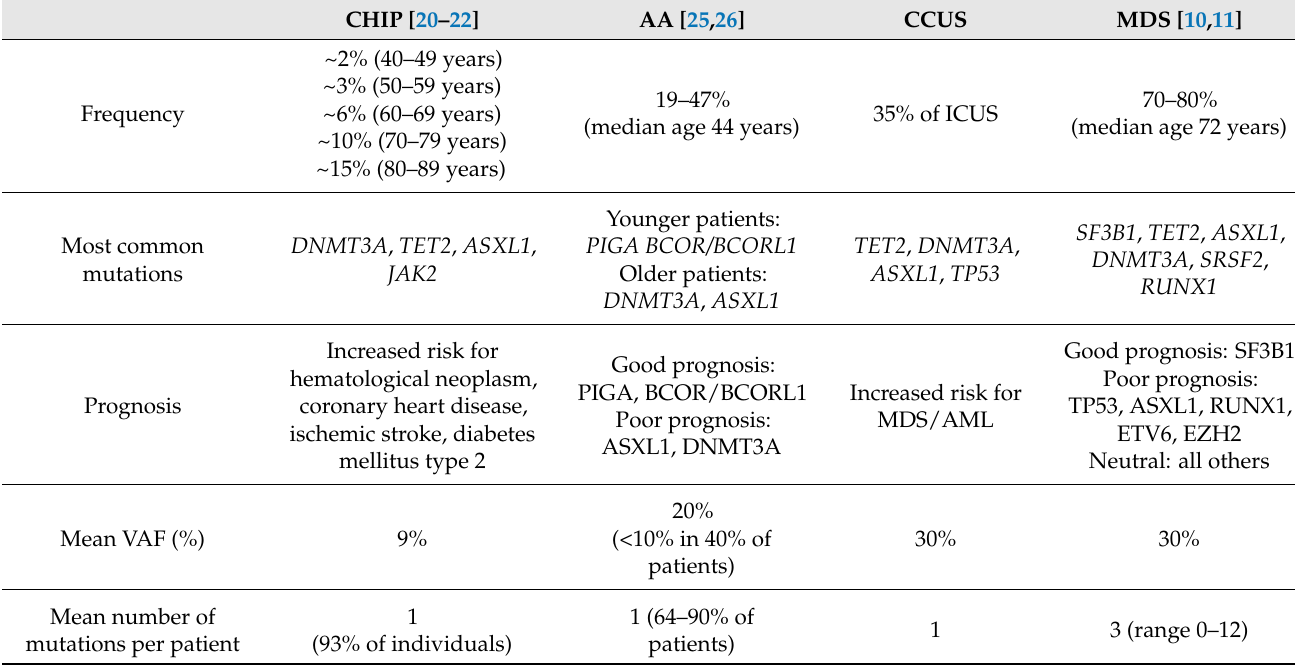
Table 3. Landscape of clonal